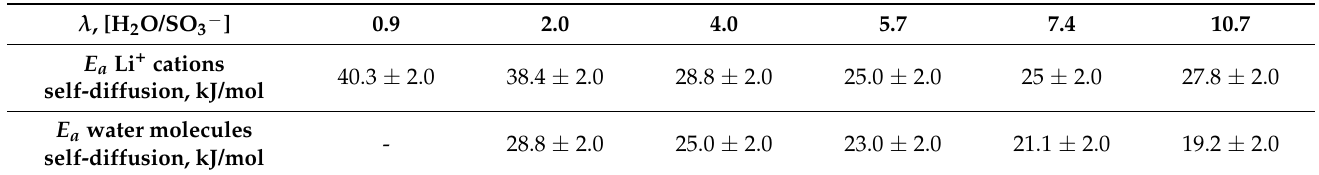
Table 7. Activation energies of Li + and water molecule self-diffusion in Li + ionic form of Nafion membrane E a at different water content λ